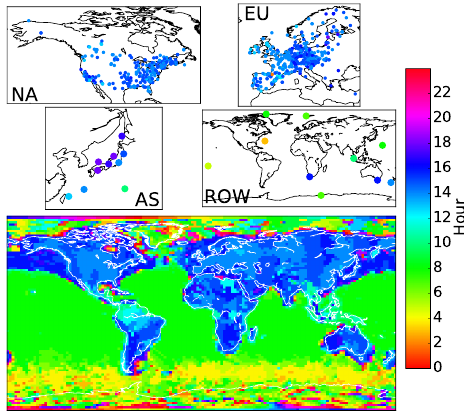
Figure 8. Diurnal amplitudes of observations (upper panels) and model (lower panel). NA is North America, EU is Europe, AS is Asia, and ROW is rest of world.